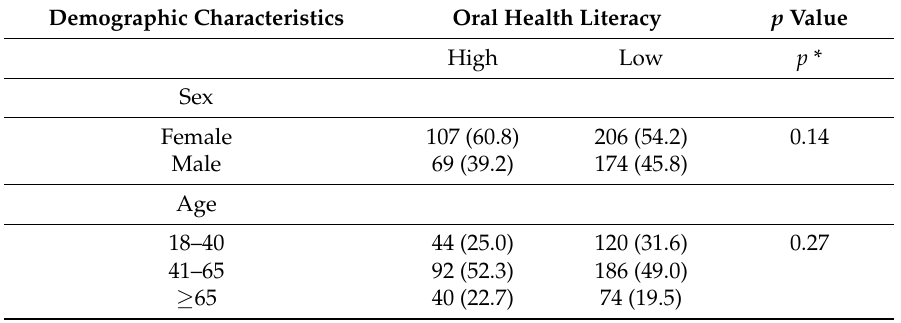
Table 2. Bivariate comparison between oral health literacy (OHL) and sociodemographic